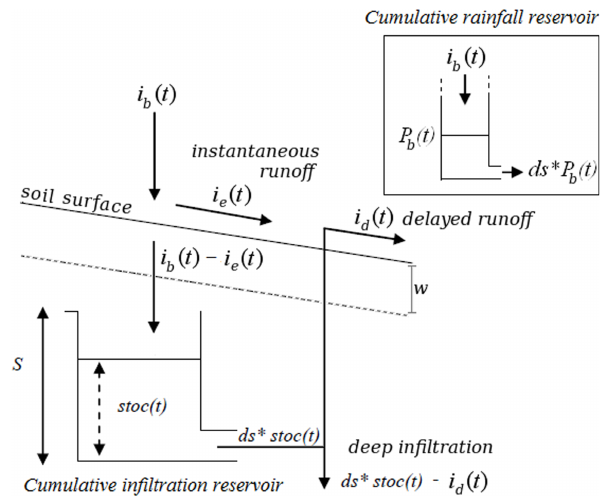
Fig. 2. Schematic representation of the ATHYS runoff production function (Bouvier and Delclaux,